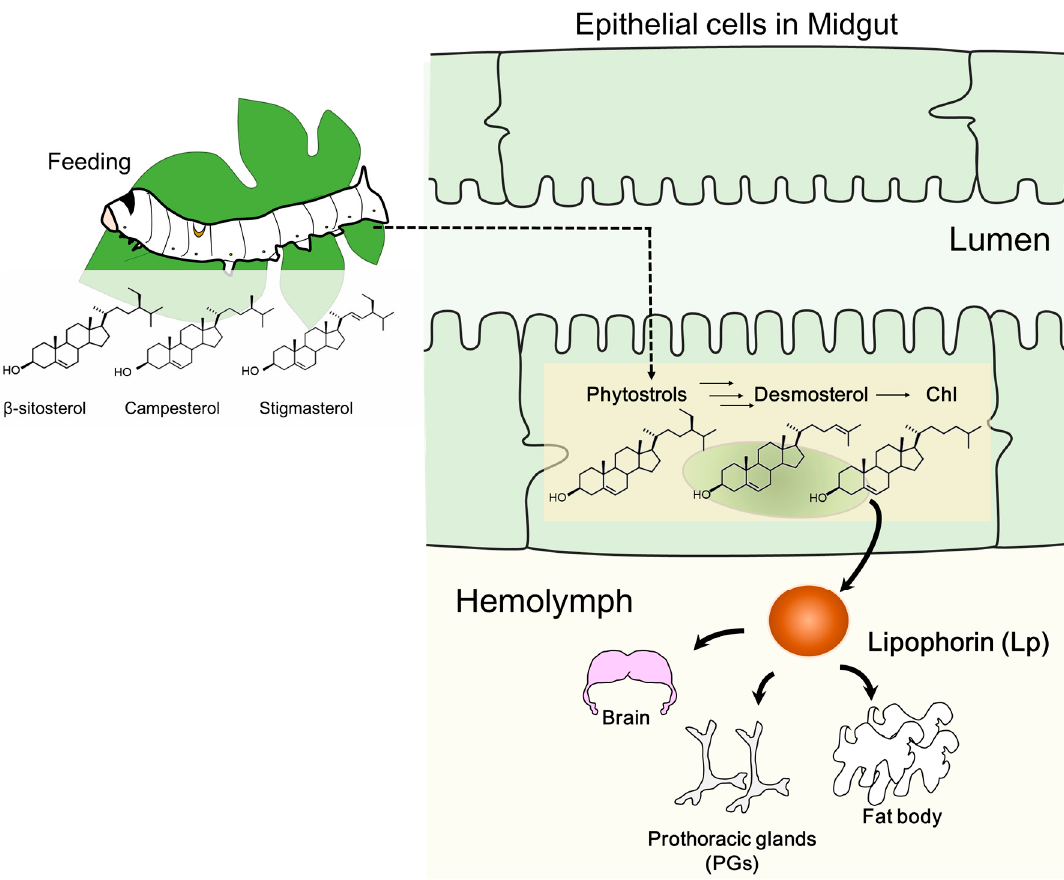
Figure 1. A model of sterol flow in the silkworm. Phytosterols obtained from diet are absorbed into midgut epithelial cells and converted into Chl, which, with other sterols, are transported into insect lipoprotein, lipophorin (Lp). Lp circulation in the hemolymph transports sterols to peripheral